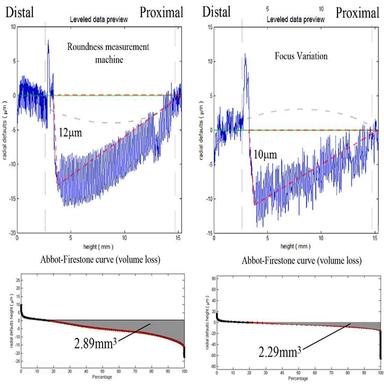
Levelled taper profile traces from the same relative location (above), showing discrepancies between RMM and focus variation measurement in replica. This translates to an under-estimation in material loss (below).